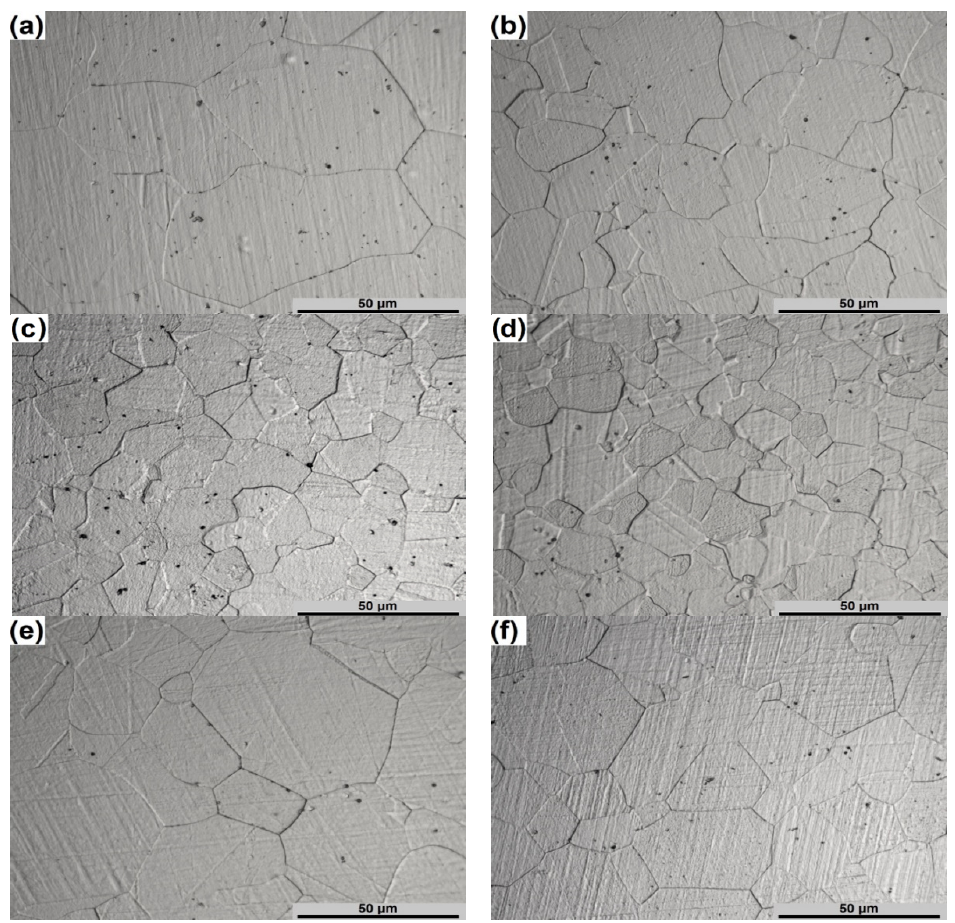
Figure 7. The microstructures of the specimens deformed under the following processing conditions: ( a ) 1050 °C/0.01 s −1 ; ( b ) 1100 °C/0.1 s −1 ; ( c ) 1100 °C/1 s −1 ; ( d ) 1100 °C/100 s −1 ; ( e ) 1150 °C/0.1 s −1 and ( f ) 1150 °C/100 s −1 .